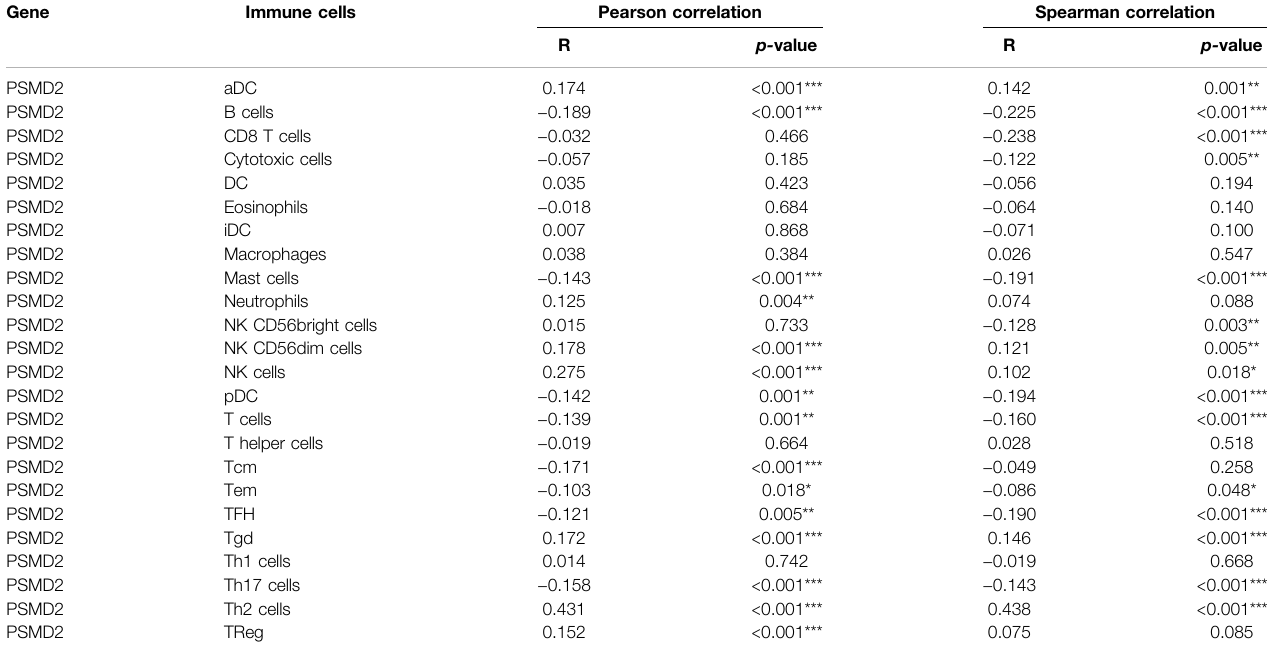
TABLE 2 | The correlation between PSMD2 expression and immune in fi ltration.